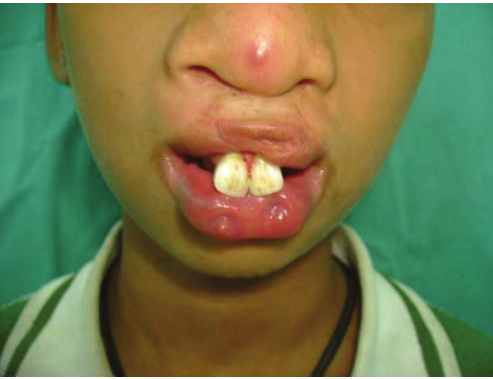
Figure 1: Maxillary central incisors hanging down along with premaxilla and bilateral pits in lower lip—frontal view.